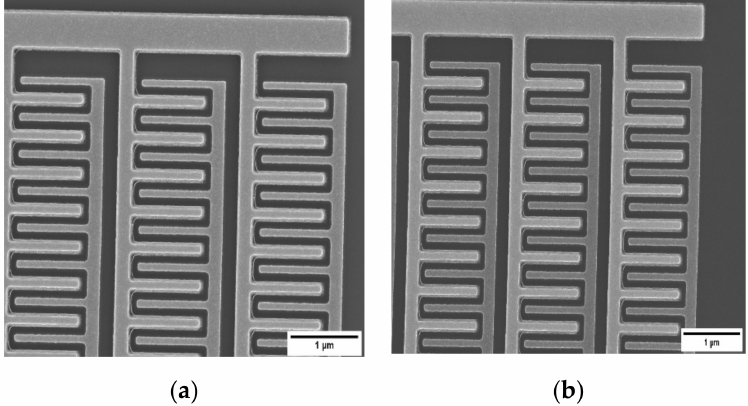
Figure 5. ( a , b ) SEM images of IDEs after the final fabrication step.